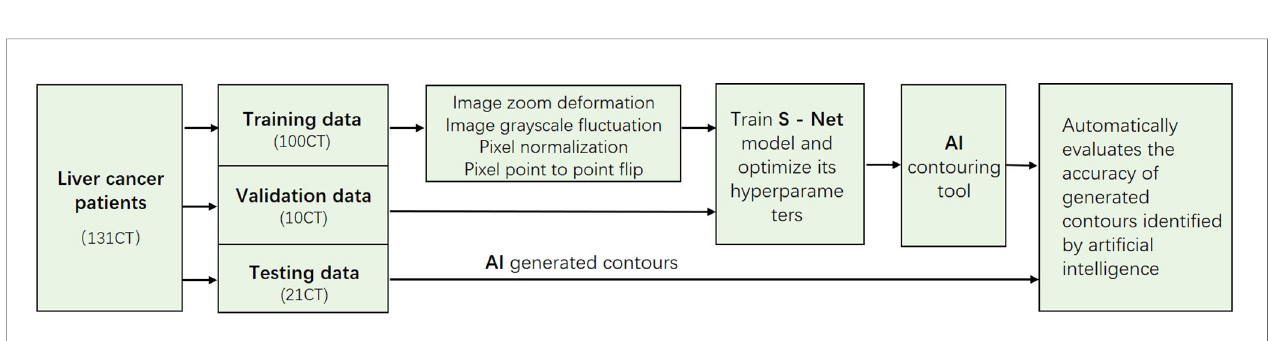
FIGURE 2 | The 2017 LiTS public dataset with a total sample of 131 patients. In this study, we adaptively partitioned the entire sample into 100 training samples, 10 validation samples, and 21 test samples. The training samples are pre-processed, and the test samples are used to evaluate the segmentation effect of the network